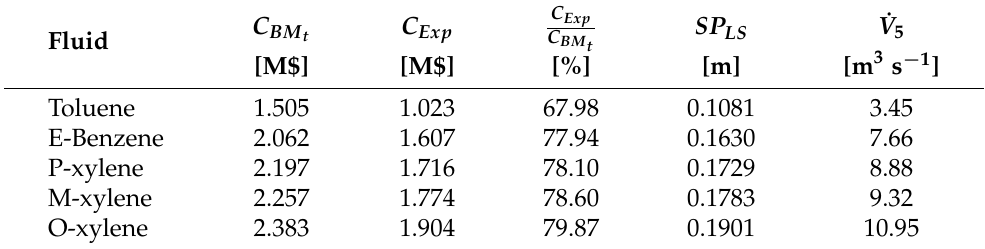
Table A10. Economic analysis results of the ORC fluids in the case of a direct exchange between the ICE exhaust and the working fluid.